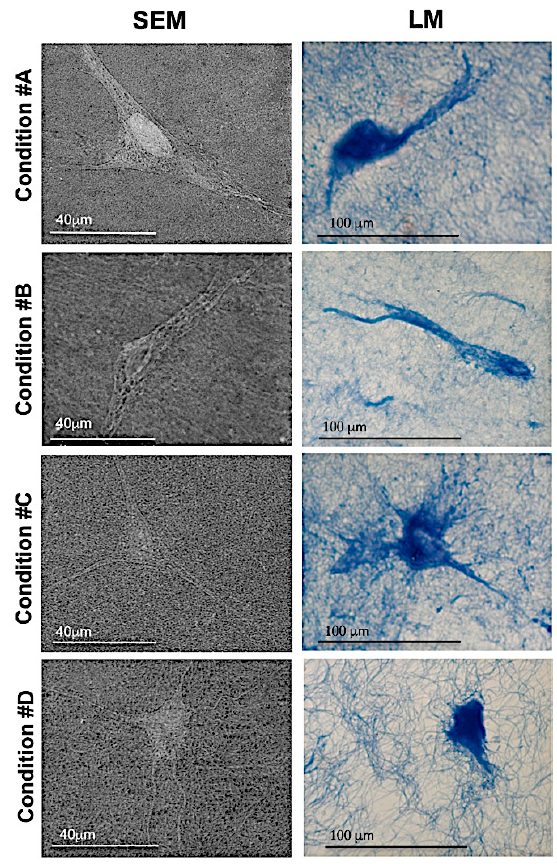
Figure 5. Morphology of fibroblasts embedded within collagen gels. Experimental conditions